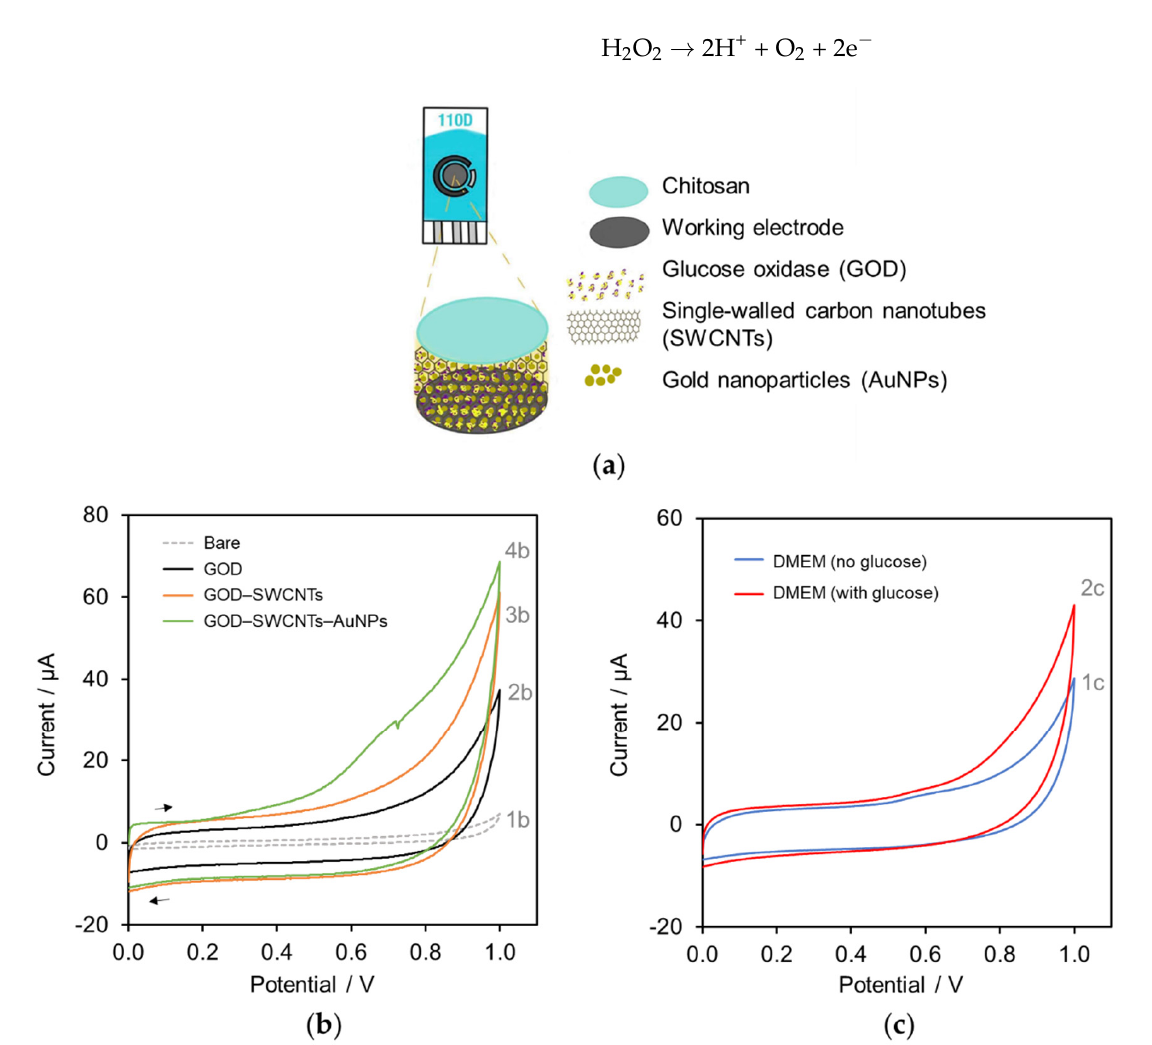
Figure 1. Modification of a SPE: ( a ) a schematic diagram showing GOD-AuNPs-SWCNTs-chitosan layer on the carbon working electrode surface (not to scale); ( b ) cyclic voltammograms of different modified electrodes; a bare commercial SPE (CV 1b), GOD-coated SPE (CV 2b), the mixing of GOD– SWCNTs-coated SPE (CV 3b), and the mixing of GOD–SWCNTs–AuNPs-coated SPE (CV 4b) in PBS; ( c ) cyclic voltammograms of GOD–SWCNTs–AuNPs-modified electrodes in DMEM in the presence of 10 mM glucose (CV 2c) and in the absence of glucose (CV 1c). Scan rate at 50 mV s − 1 .